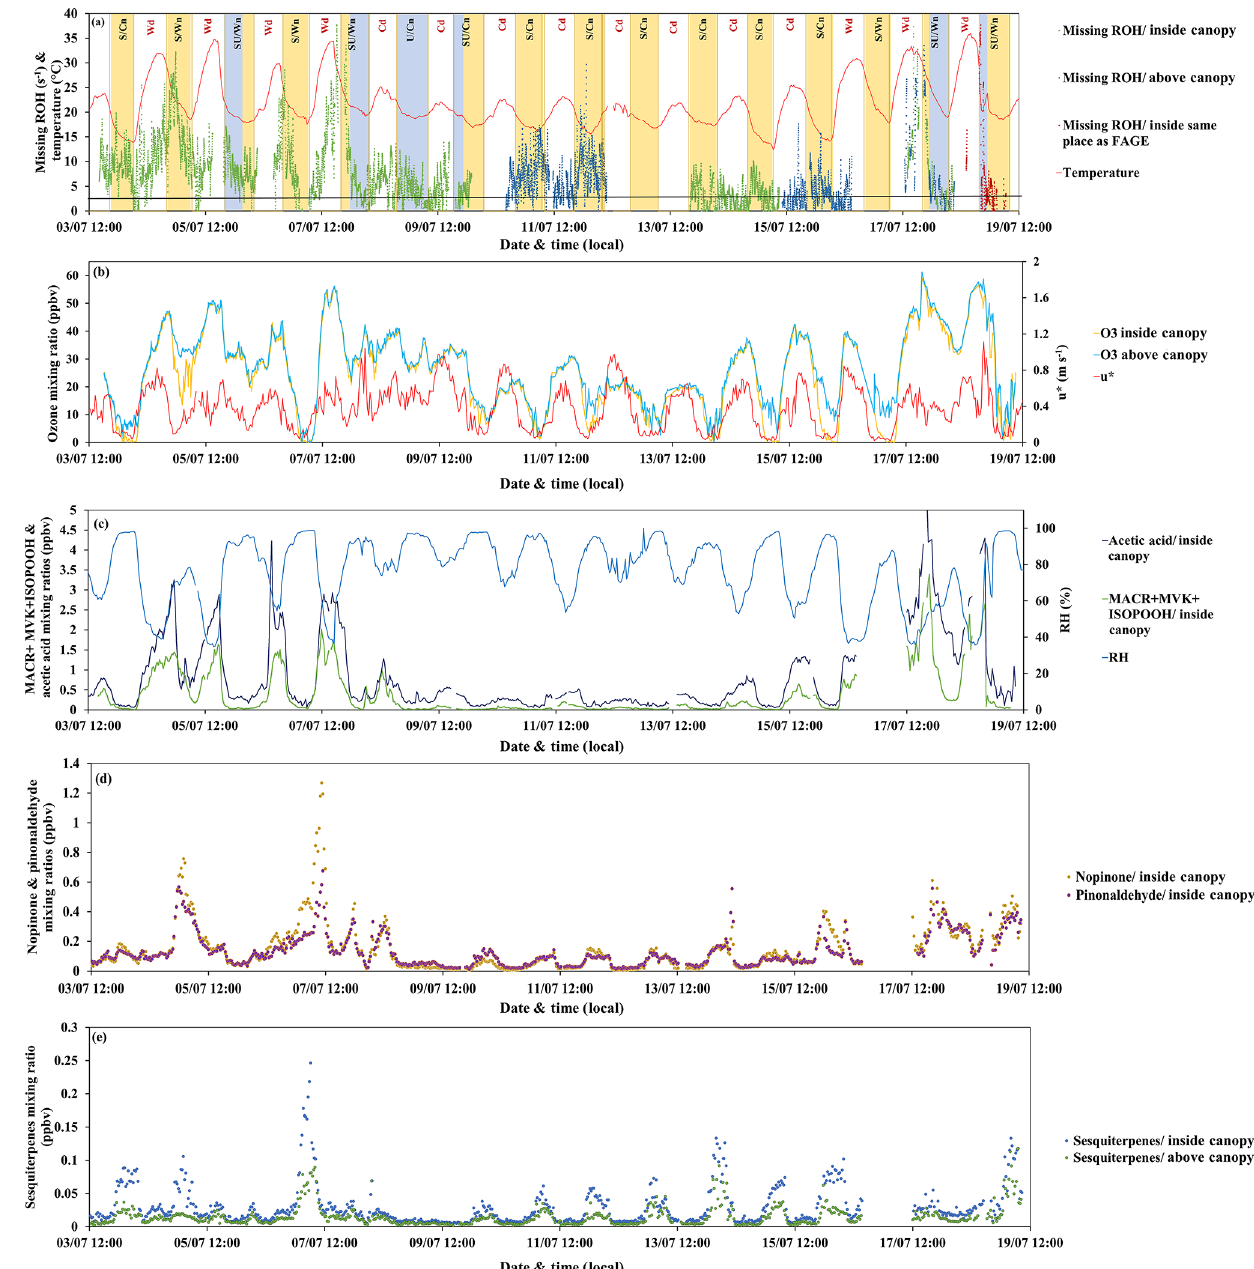
Figure 8. Missing OH reactivity inside and above the canopy together with (a) temperature, (b) friction velocity (red), ozone mixing ratios inside (yellow) and above (blue) the canopy, (c) relative humidity (clear blue), MACR + MVK + ISOPOOH (dark blue) and acetic acid (green) inside the canopy, (d) nopinone (yellow) and pinonaldehyde (purple) inside the canopy, and (e) sesquiterpenes inside (blue) and above (green) the